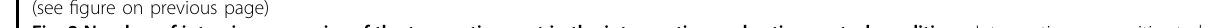
Fig. 2 Number of intrusive memories of the traumatic event in the intervention and active control conditions. Intervention = cognitive task (trauma memory reminder cue plus Tetris computer game play using mental rotation); Active control condition = attention placebo task (listening to podcast). a Violin plots displaying mean number of intrusive memories recorded in a daily diary during week 1 after completing the intervention/ control procedure following a traumatic event. Error bars depict standard errors. Points depict the total number of intrusive memories (per week) of each participant. Violins depict smoothed density. Plots were created with the pirate plot function of the ‘ yarrr ’ package (Version 0.1.5) 50 in R 42 . b Violin plots displaying mean number of intrusive memories recorded in a daily diary during week 5 (as above). c Bar graphs displaying mean number of intrusive memories recorded in a daily diary during week 1 after completing the intervention/control procedure following a traumatic event. Error bars depict standard deviations (for comparison with Iyadurai et al. 3 , Fig. 2). d Bar graphs displaying mean number of intrusive memories recorded in a daily diary during week 5 (as above). e Frequency scattergraphs displaying the time course of the number of intrusive memories recorded in a diary during week 1 after completing the intervention/control procedure following a traumatic event. The size of the circles represents the number of participants who reported the indicated number of intrusive memories on that particular day, scaled separately for each condition (see also Supplementary Information for Fig. 2e). f Frequency scattergraphs displaying the time course of the number of intrusive memories recorded in a diary during week 5 (as